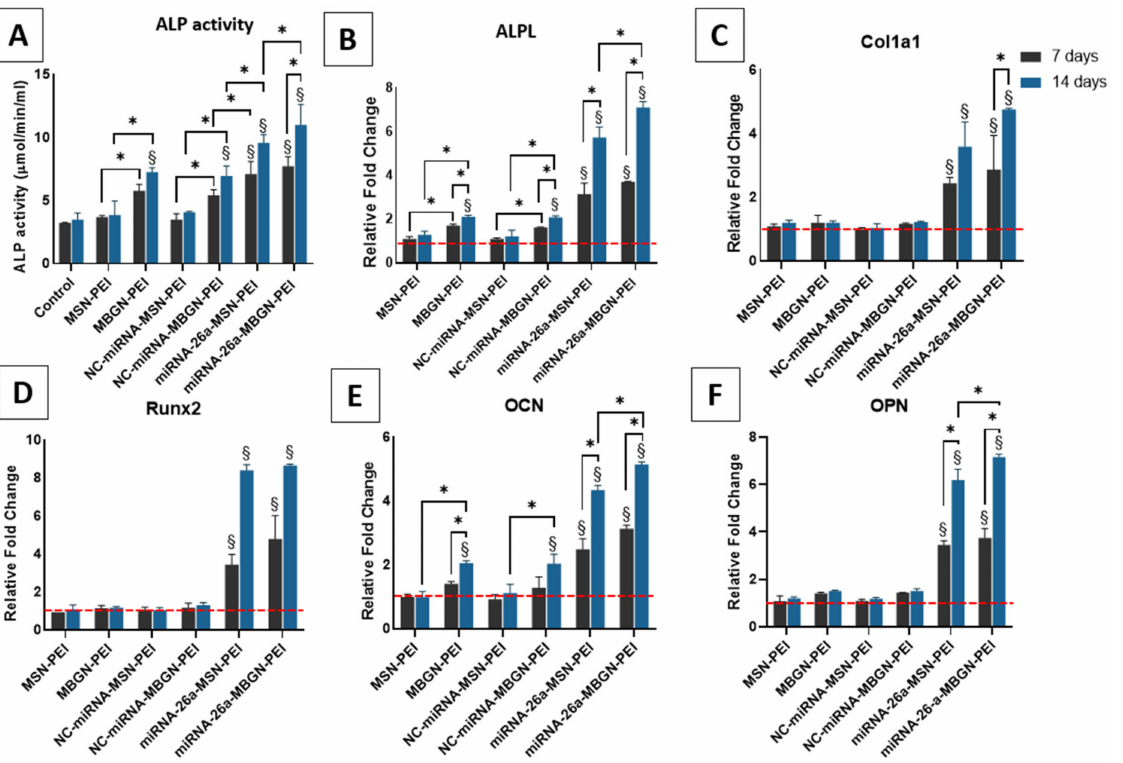
Figure 7. ALP activity assay (panel ( A )) and gene expression (panels ( B – F )) after treatment with MSN-PEI or MBGN-PEI loaded negative control (NC)-miRNA. Osteogenic-related mRNA expression after transfected with negative control (NC)-miRNA-MSN-PEI, MSN-PEI, NC-miRNA-MBGN-PEI, MBGN-PEI, or control for 7 (black bars) and 14 days (grey bars). Results are shown as mean ± SD. Red lines indicate the gene expression level from the blank control group. § p < 0.05 compared to the control group and * p < 0.05 compared to the experimental groups by post hoc Tukey tests ( n =